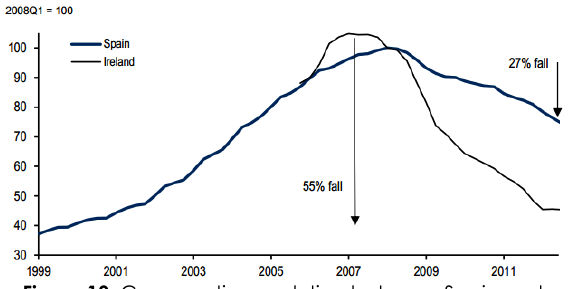
Figure 19. Comparative evolution between Spain and Ireland bubble effects. Source: Credit Suisse studies unit.